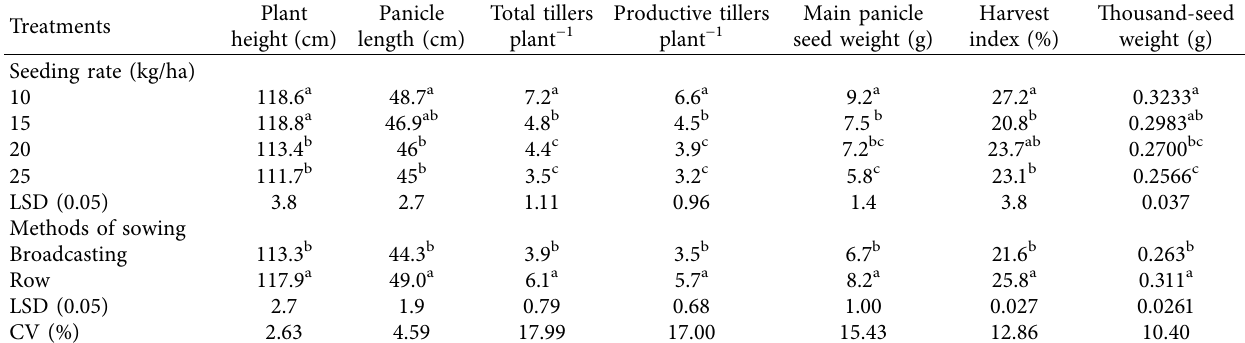
Table 2: Main effect of the seed rate and method of sowing on plant height, panicle length, total tillers, productive tillers, main panicle seed weight, and harvest index of